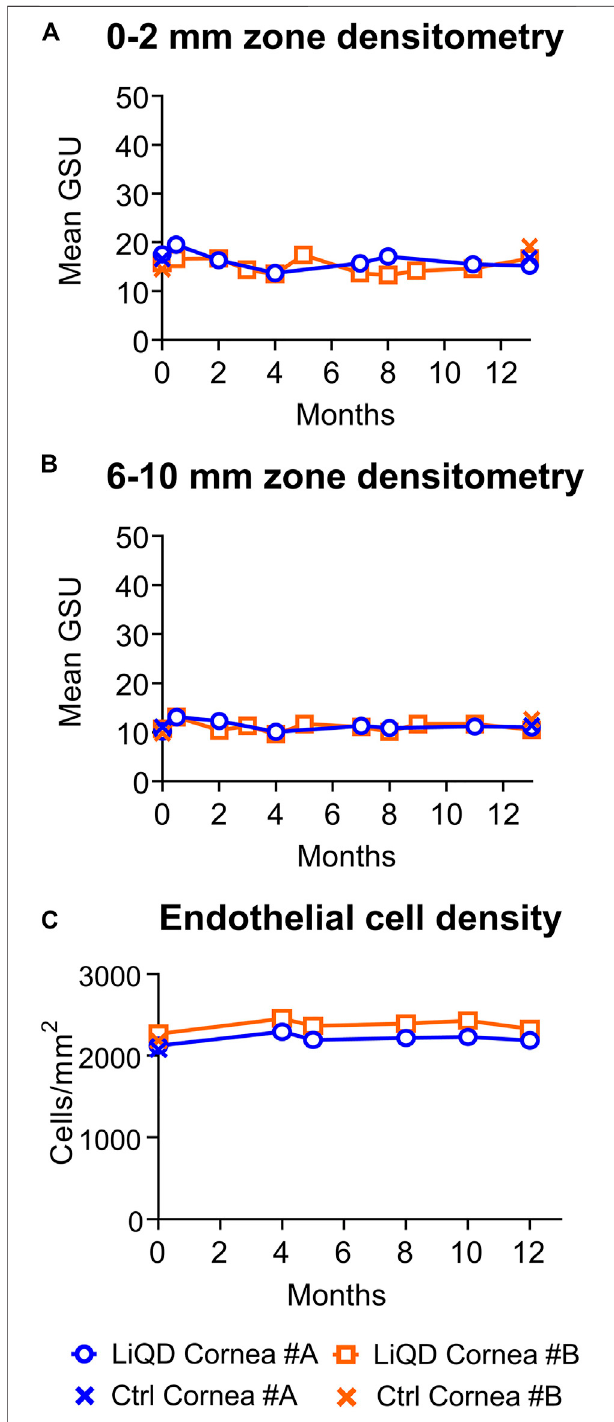
FIGURE 4 | Corneal densitometry. Mean densitometry values in standardizedgreyscaleunits(GSU)inthe2 mmdiametercentral cornealzone (A) and in the 6 – 10 mm diameter peripheral ring shape zone covering the implants (B) asafunctionoftimeforoperatedeyesandpriortosurgeryin non-operated mate controls. Endothelial cell density. Mean endothelial cell counts as a function of time for operated eyes and non-operated mate controls (C)